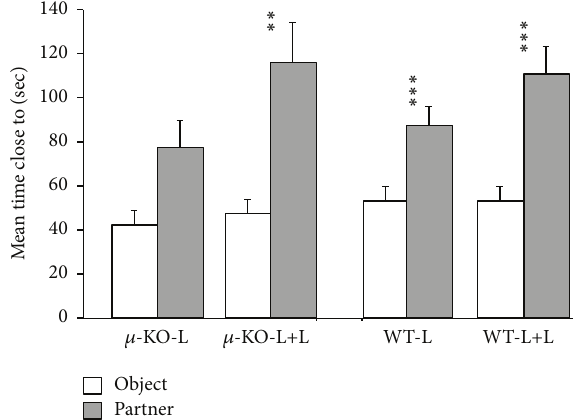
Figure 2: Mean time (+SEM) spent by juvenile male and female PND28 mice close to an object or to a same age/sex NMRI outbred partner in the Social Approach-Avoidance Test. 𝑁 : 14–18 per group. 𝜇 -KO-L: Oprm1 −/− pups reared by their mother [8 males + 6 females]; 𝜇 -KO-L+L: Oprm1 −/− pups reared by their mother plus a second lactating female [8 males + 10 females]; WT-L: Oprm1 +/+ pups reared by their mother [8 males + 9 females]; WT-L+L: Oprm1 +/+ pups reared by their mother plus a second lactating female [8 males + 8 females]. Preference of partner versus object: ∗∗ 𝑝 < 0.01 , ∗∗∗ 𝑝 < 0.005